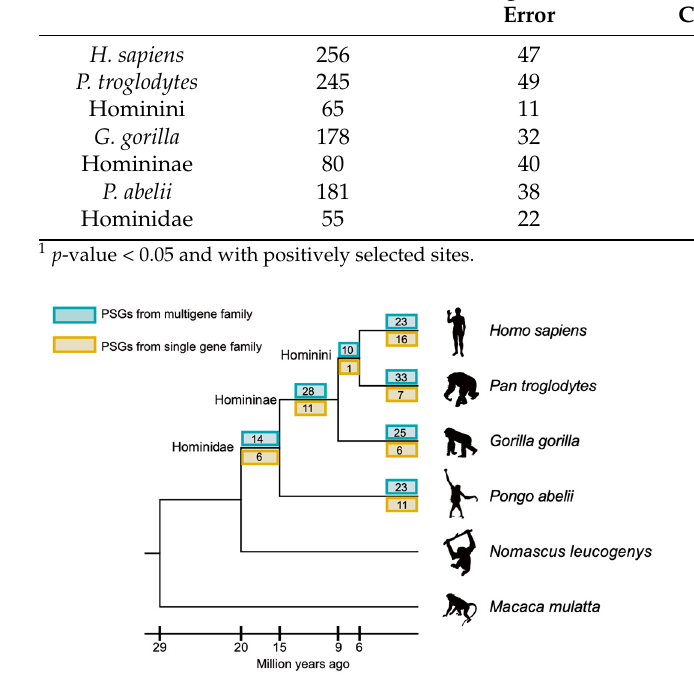
Figure 1. The number of PSGs in each great ape lineage. Blue and yellow numbers show the number of PSGs in multigene families and single-gene families, respectively. The times of branches come from the TimeTree website (http://www.timetree.org/, last accessed 3 July 2019). Animal illustrations are from phylopic.org, and are credited to NASA ( H. sapiens ,